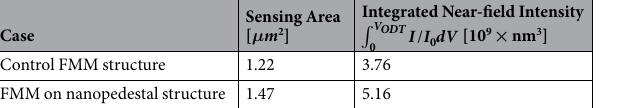
Table 1. Calculation results of effective area for sensing and integrated E-field intensity over the sensing volume of the two FMM structures. 30 nm of undercut etching depth was used for the FMM on the nanopedestal